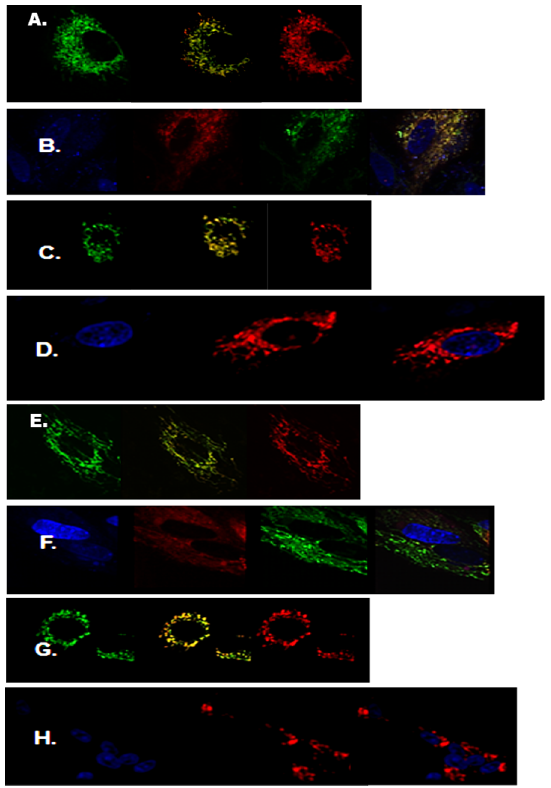
Figure 3. Mitochondrial staining with MitoTracker H green (total mitochondria) and MitoTracker red H (active function mitochondria) shows different morphology in cells at a given time indicative of rapid changes in movement and mitochon- drial function as exemplified by the saline controls (A, B, C and D). Anterograde mitochondrial movement (away from the cell nuclei) was observed after treatment with 20 m M lithium (E) and 50 m M Paliperidone (F) as indicated by long filamentous mitochondria. Ballooning and concentration around cell nuclei (blue) was observed after treatment with 50 m M Clozapine (G). Detrimental effects were observed in mitochondria after treatment with 50 m M Haloperidol (H). Superimposed images shown in